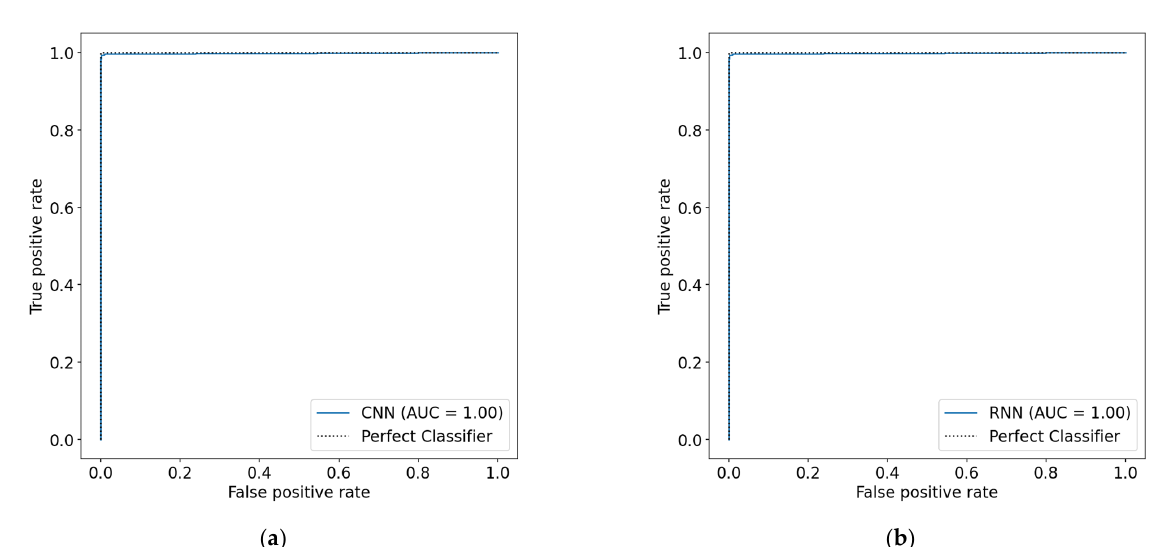
Figure 14. AUC measures after data augmentation. ( a ) 1D-CNN model; ( b ) Bi-LSTM model. A comparative analysis was conducted against conventional ML and DL algorithms such as SVM and ANN to further validate the performance of the proposed 1D-CNN and